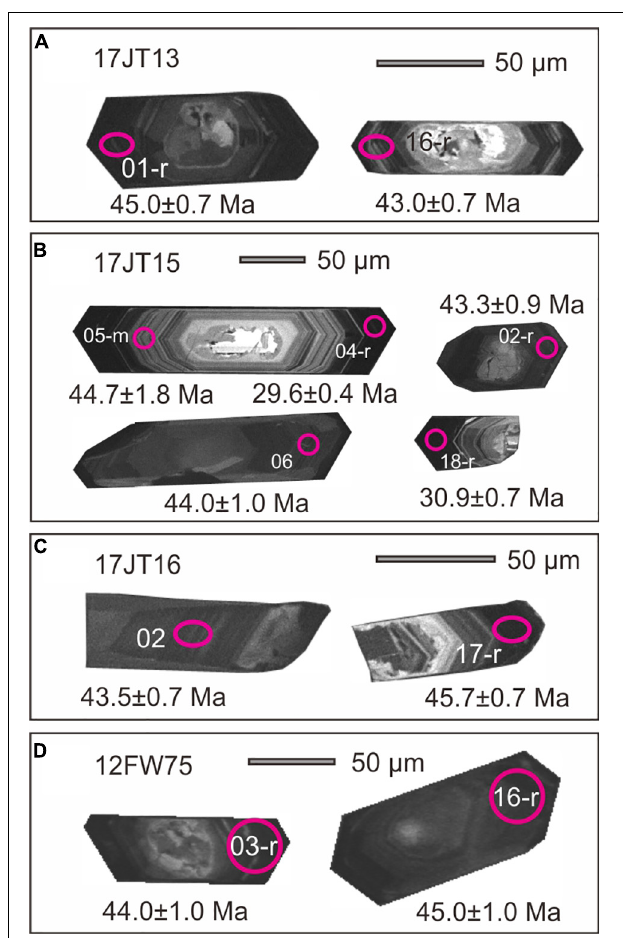
FIGURE 3 | Representative cathodoluminescence (CL) images for zircons from Haweng granodiorite porphyries. The analytical spots for SIMS method (A,C) are elliptic of 10 × 15 µ m in size, whereas the LA-ICP-MS spots are circular, 15 µ m for 17JT15 (B) and 30 µ m for 12FW75 (D)